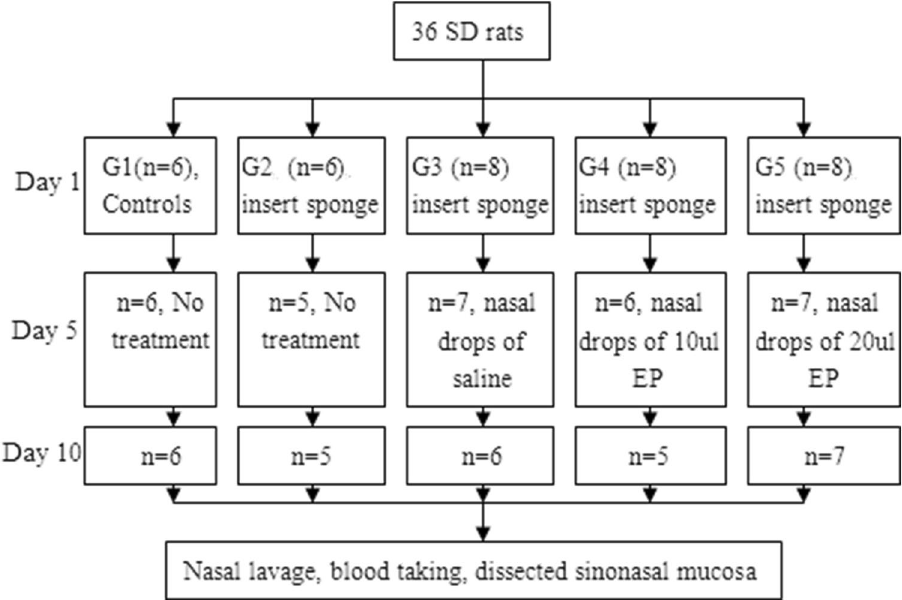
Figure 1. Group assignment. G group, EP ethyl